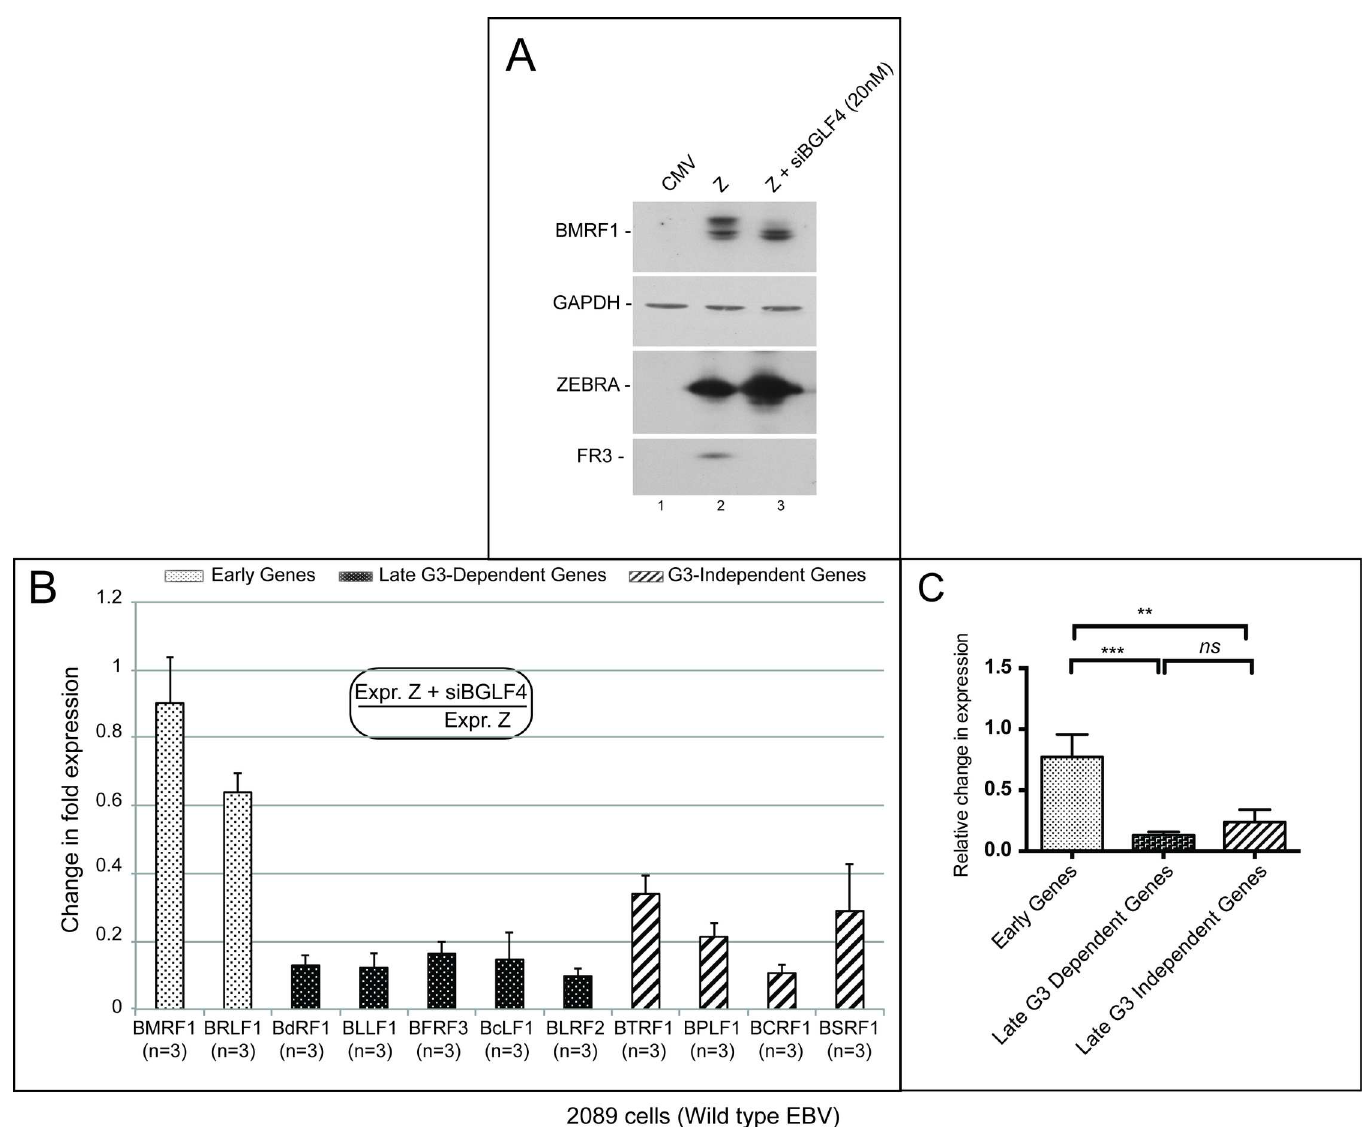
Fig 9. BGLF4 regulates expression of the BGLF3-independent subclass of late genes. A) Immunoblotdemonstrating the effect of silencingexpression of BGLF4 on the phosphorylation of BMRF1 and the expressionof the late viral capsid FR3 protein. B) The bar graph illustratesthe effect of silencingBGLF4 on the transcript level of early, BGLF3-dependentand BGLF3-independentlate genes. The data were compiledfrom replicateexperiments indicatedfor each transcript by (n). C) The bar graph demonstrates the combinedchangesin fold expressionamong the three subclassesof lytic genesas a result